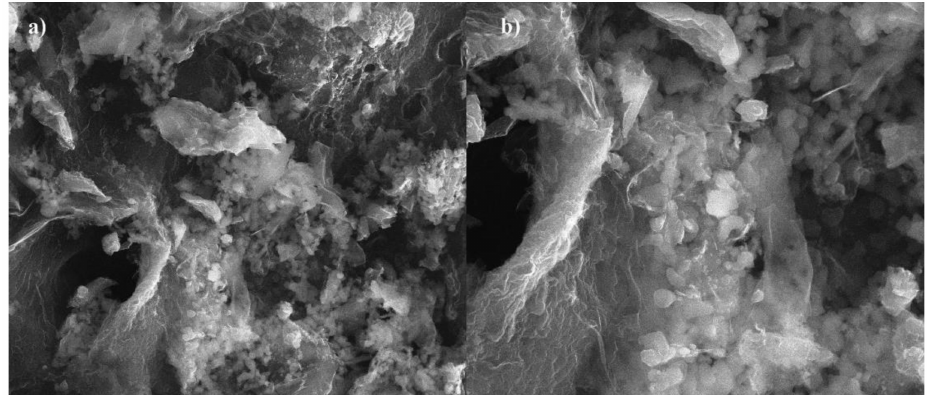
Figure 3. SEM images of biochar in the scale of ( a ) 10 µ m and ( b ) 4 µ m. The EDXRF analysis (Figure 4) revealed that the studied porous material possesses significant amounts of potassium, calcium, phosphorus and magnesium. The presence of these metals in biochar is beneficial for the metal adsorption process. They can exchange or precipitate with the studied metals and reduce their availability. The reported adsorp- tion kinetic results indicate that the adsorption of heavy metals by the cation exchange mechanism in the biochar occurs at the early stage of the reaction. Park et al. and Lu et al. reported that the effects of cation exchange on the adsorption of heavy metals for rice straw and sludge biochar were equal to 62.3% (Cu 2+ ) and 51.8% (Pb 2+ ), respectively [14,15].